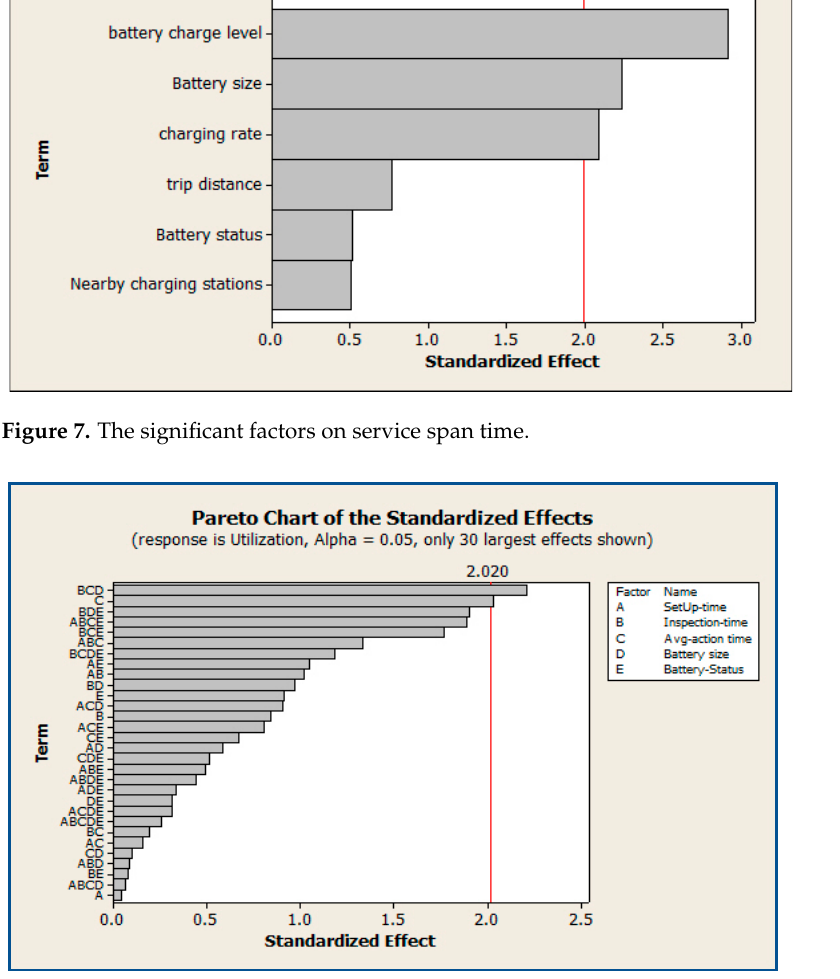
Figure 8. The significant factors on